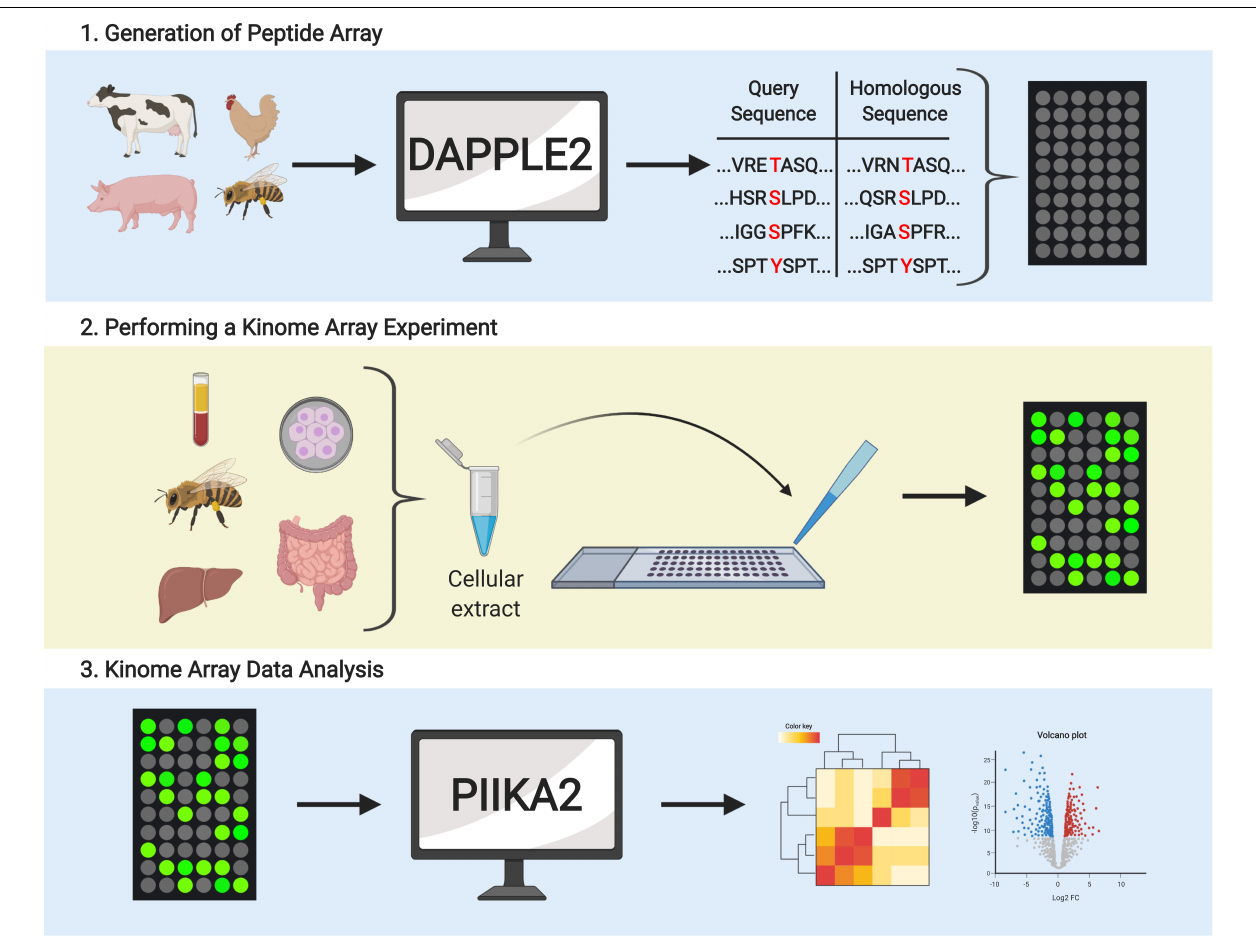
FIGURE 3 | Overview of the kinome array workflow. Schematic representation of the three main components of the kinome array pipeline. (1) Computational workflow (DAPPLE2) for predicting putative phosphoacceptor peptides for spot printing on peptide microarrays. (2) Representation of the various cells, tissues and whole organisms in which cellular extracts can be prepared to quantify kinase-mediated phosphorylation using peptide arrays. (3) Computational workflow (PIIKA2) for transforming, statistical analysis and graphical visualization of kinome array